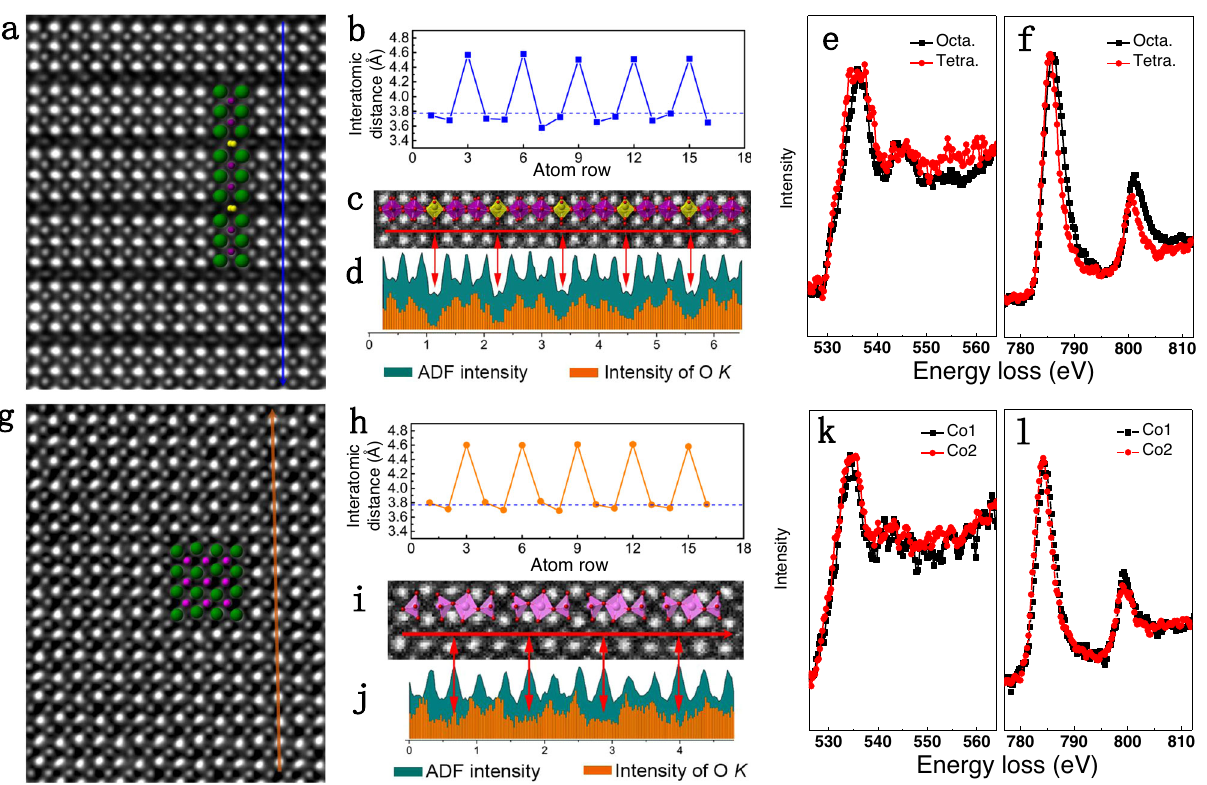
Fig. 2 Atomic-resolved HAADF images and electron energy loss spectra of LCO 2.67 and nLCO 2.5 phases. HAADF images of a LCO 2.67 and g nLCO 2.5 phase with overlaid structural model, where green spheres represent La, purple and yellow spheres represent Co in octahedral and tetrahedral layers, the O are omitted for clarity. Dark blue and yellow lines indicated the acquired positions of EELS spectra. Periodic change of out-of-plane La – La distances in the b LCO 2.67 phase and h nLCO 2.5 phase, the 3.79 Å is indicated by dotted line. Local HAADF images overlaid with projected polyhedra and corresponding periodic change of intensity of ADF signal and O K- edge in LCO 2.67 phase ( c, d ) and nLCO 2.5 phase ( i, j ). Red double arrows indicate the correspondence between the HAADF image and EELS results. The normalized O K -edge and Co L -edges of the LCO 2.67 phase ( e, f ) and the nLCO 2.5 phase ( k, l